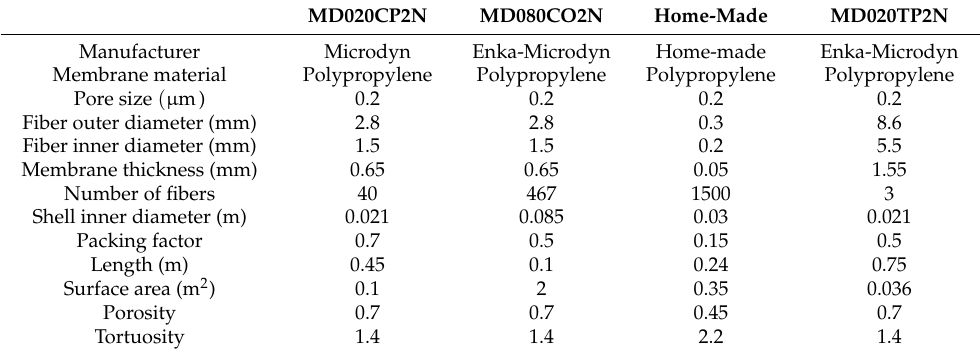
Table 1. DCMD modules characteristics and membrane properties [11].